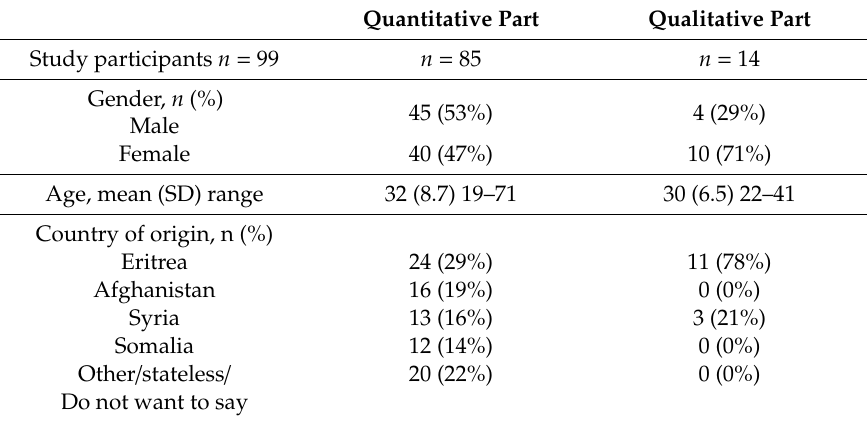
Table 1. Demographic characteristics of study